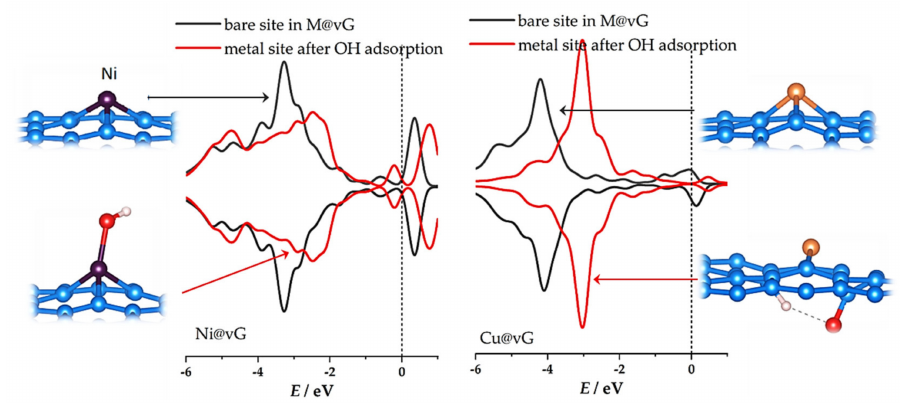
Figure 9. The comparison of DOS of metal centers for Ni@vG and Cu@vG before and after the addition of OH to the system. The energy scale is referred to the Fermi level (vertical dashed